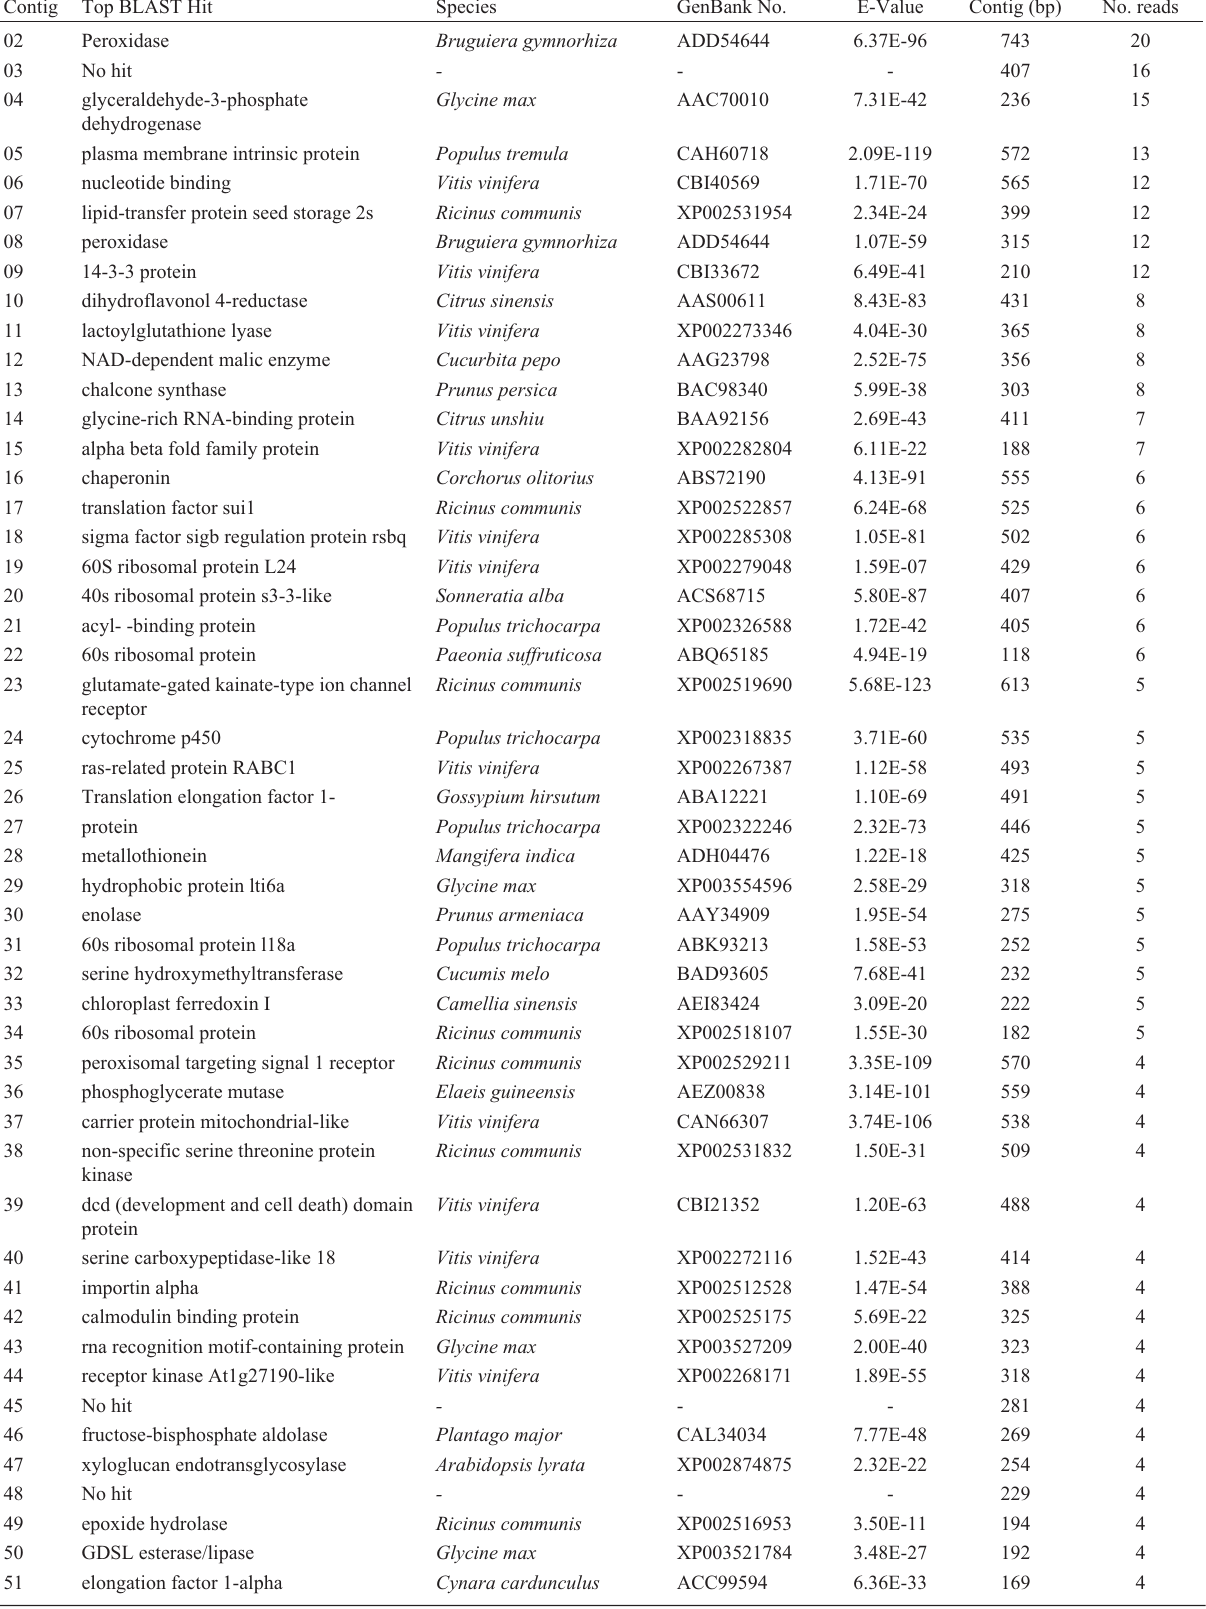
Table 2 - Top BLAST hits of terrestrial SSH library assembled contigs containing 2 or more reads. Contig Top BLAST